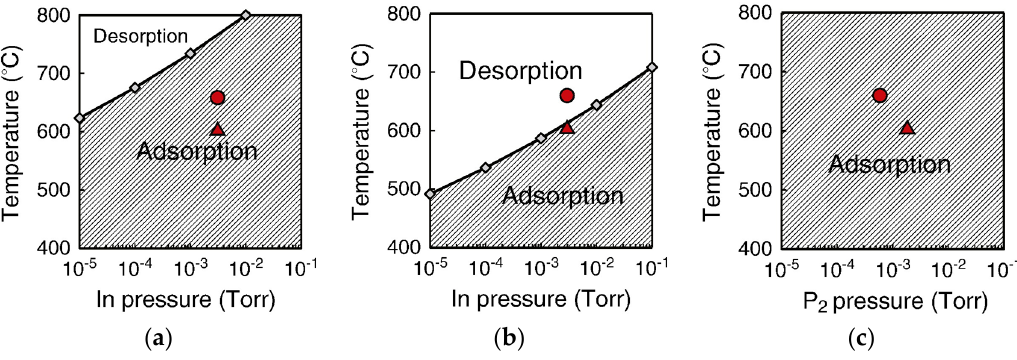
Figure 25. Calculated phase diagrams as functions of temperature and pressure in the growth process shown in Figure 21. Panels ( a ) and ( b ) show adsorption–desorption behavior of an In atom on the surface with θ In = 1/4 and 2/4, respectively. Panel ( c ) illustrates adsorption–desorption behavior of a P atom on the surface with θ In = 3/4. Regions with hatched lines correspond to atom-adsorbed regions. Red circles and triangles represent the growth conditions (A) and (B), respectively. Reprinted with permission from [97]. Copyright (2013) by Elsevier.